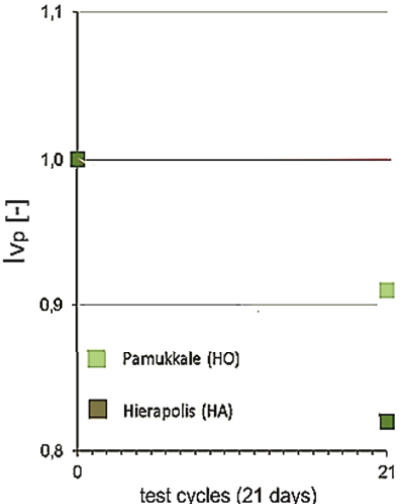
Fig. 7. Strength reduction index I Rc after the impact of SO 2 in the presence of humidity